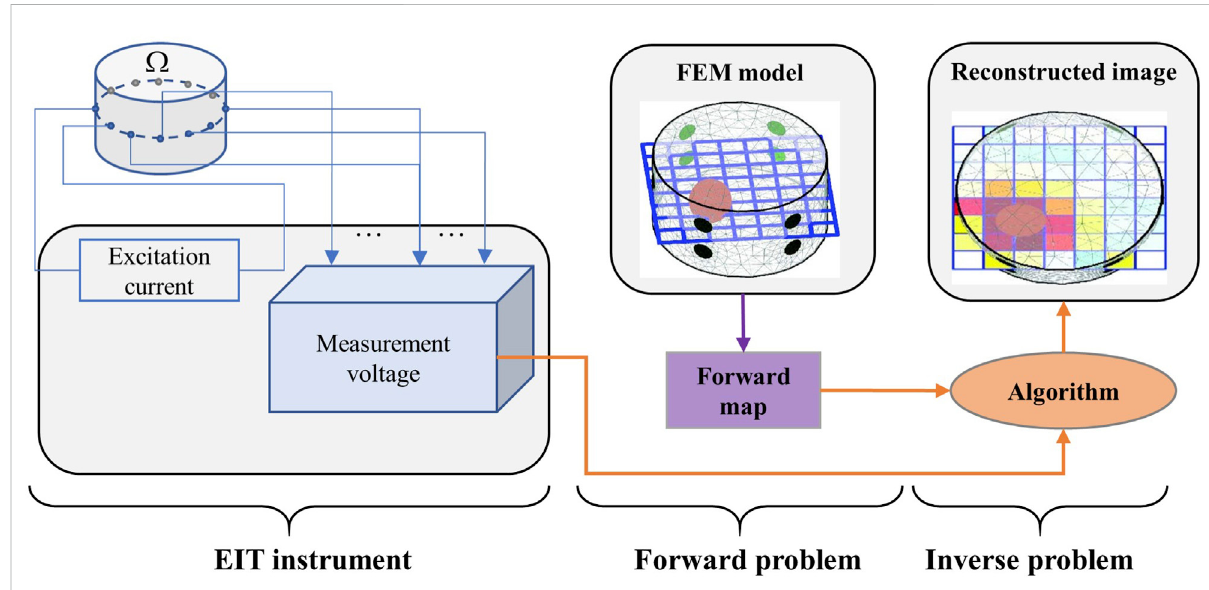
FIGURE 1 Typical schematic of image reconstruction. Left part: EIT measuring data from body Ω . Middle part: EIT forward problem for a fi nite element model of the body. Right part: EIT inverse problem, where forward mapping and reconstruction algorithms are used to reconstruct the EIT image from measured data (Lionheart and Adler,